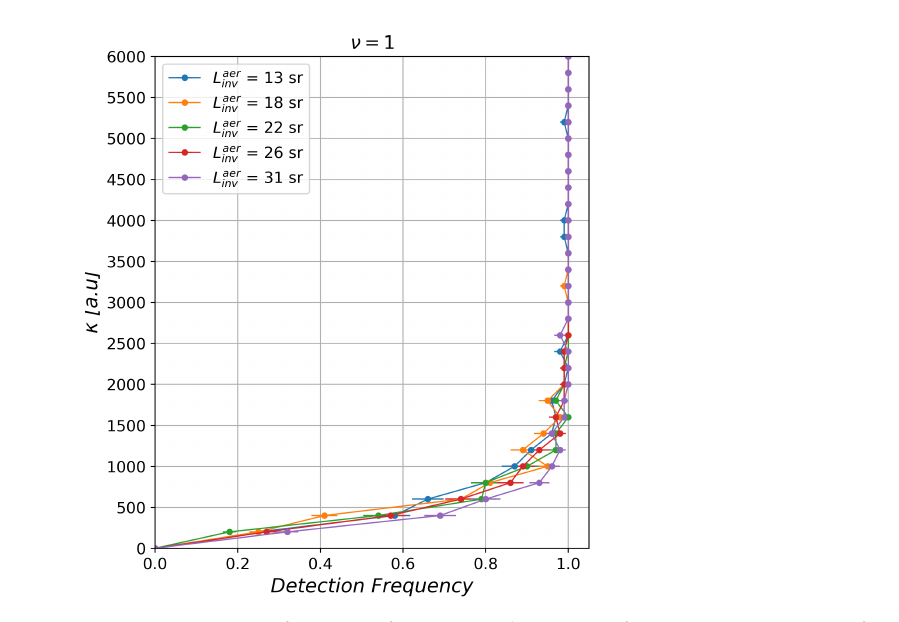
Figure 8. Detection frequency for ν = 1 and κ varying from 1 to 6000 in steps of 200. Different colors indicate the L inv aer values